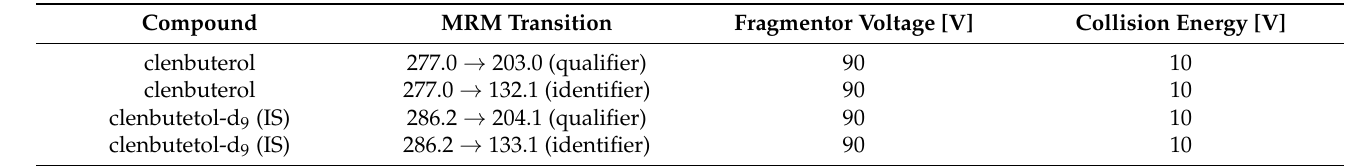
Table 1. Multiple reaction monitoring (MRM) transitions and optimized mass spectrometer pa- rameters used for the determination of clenbuterol and corresponding internal standard (IS) by SPE–UHPLC–MS/MS